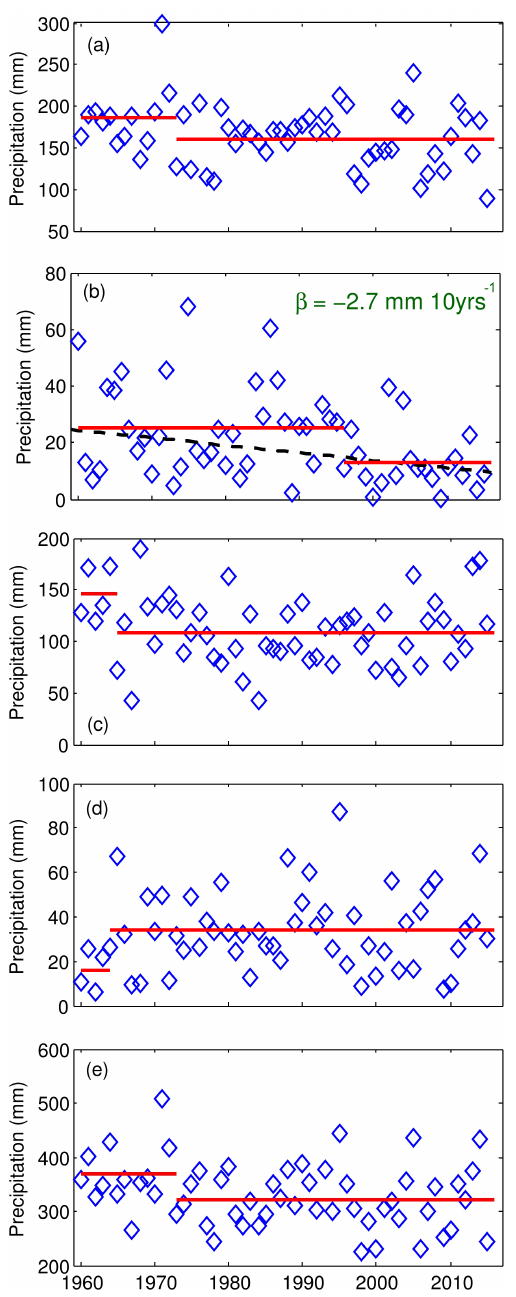
Figure 4. Observed seasonal and annual precipitation for each water year (October–September) from 1960 to 2015. (a) Win- ter (October–April), (b) spring (May), (c) summer (June–August), (d) fall (September) and (e) annual. The slope ( β ) is shown in mmdecade − 1 for statistically significant trends at the p ≤ 0 . 05 sig- nificance threshold. The solid red line shows the annual change